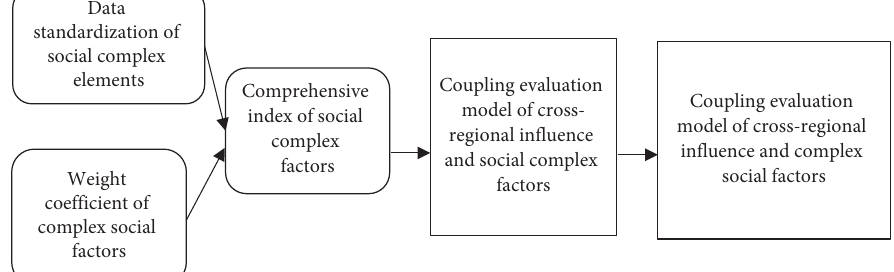
Figure 1: Schematic of coupling evaluation